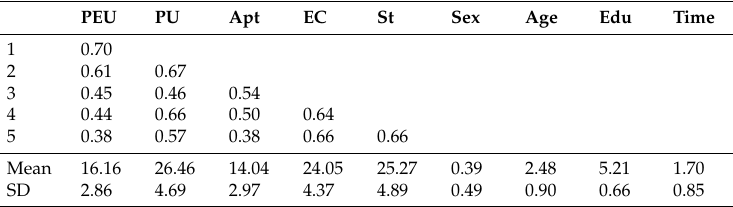
Table 1. Correlation Matrix and Descriptive Statistic Measures.